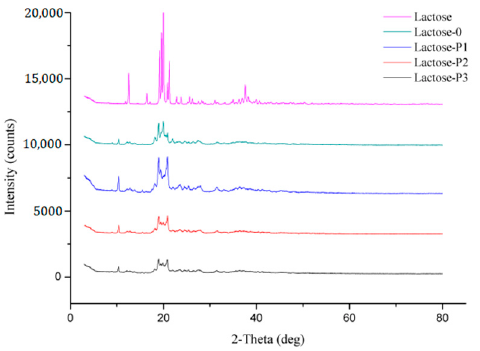
Figure 2. Representative X-ray diffractograms of materials. Lactose, the raw material; Lactose-0, processed without PVP K30; Lactose-P1, processed with 1% PVP K30; Lactose-P2, processed with 2% PVP K30; Lactose-P3, processed with 3% PVP K30.